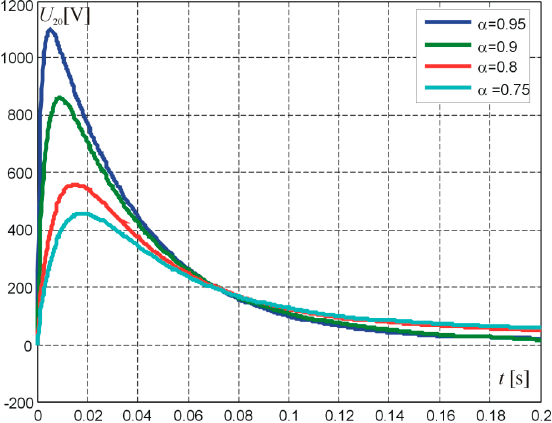
Figure 10. Voltage curves at the output of a two-port network with rectangular-pulse forcing for α = 0.95, 0.9, 0.8, 0.75.